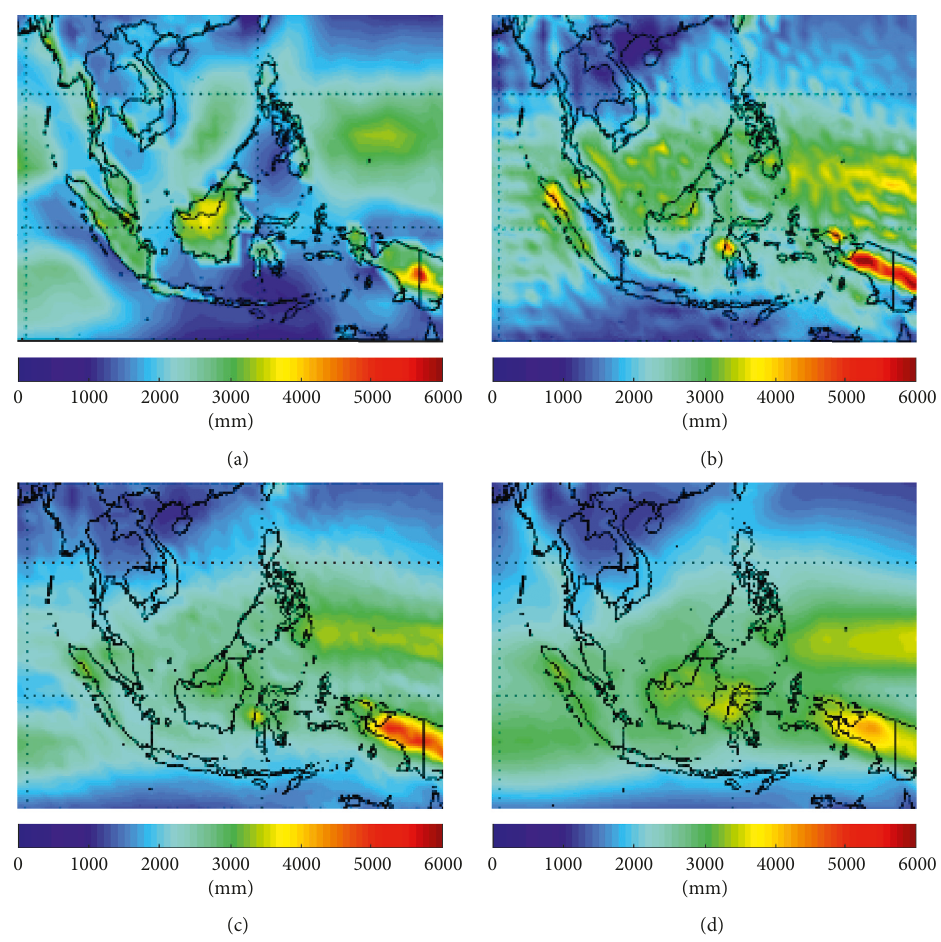
Figure 10: Comparisons of the mean annual precipitation (Mean-P) (mm · y − 1 ) for years 1960–1999 of (a) observations, (b) CNRM-CM5-2, (c) 6-GCM-Ensemble, and (d)